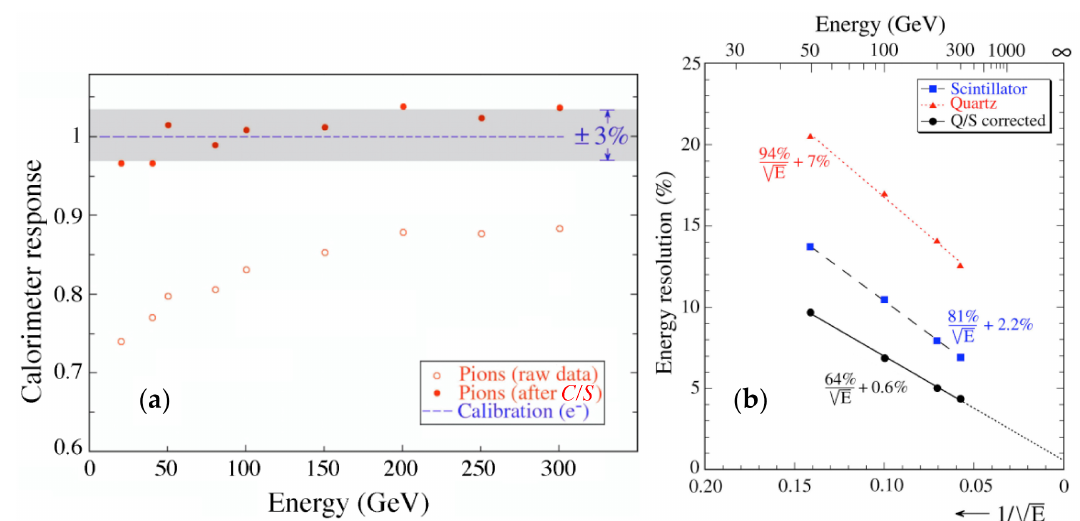
Figure 7. Results of pion detection with the DREAM